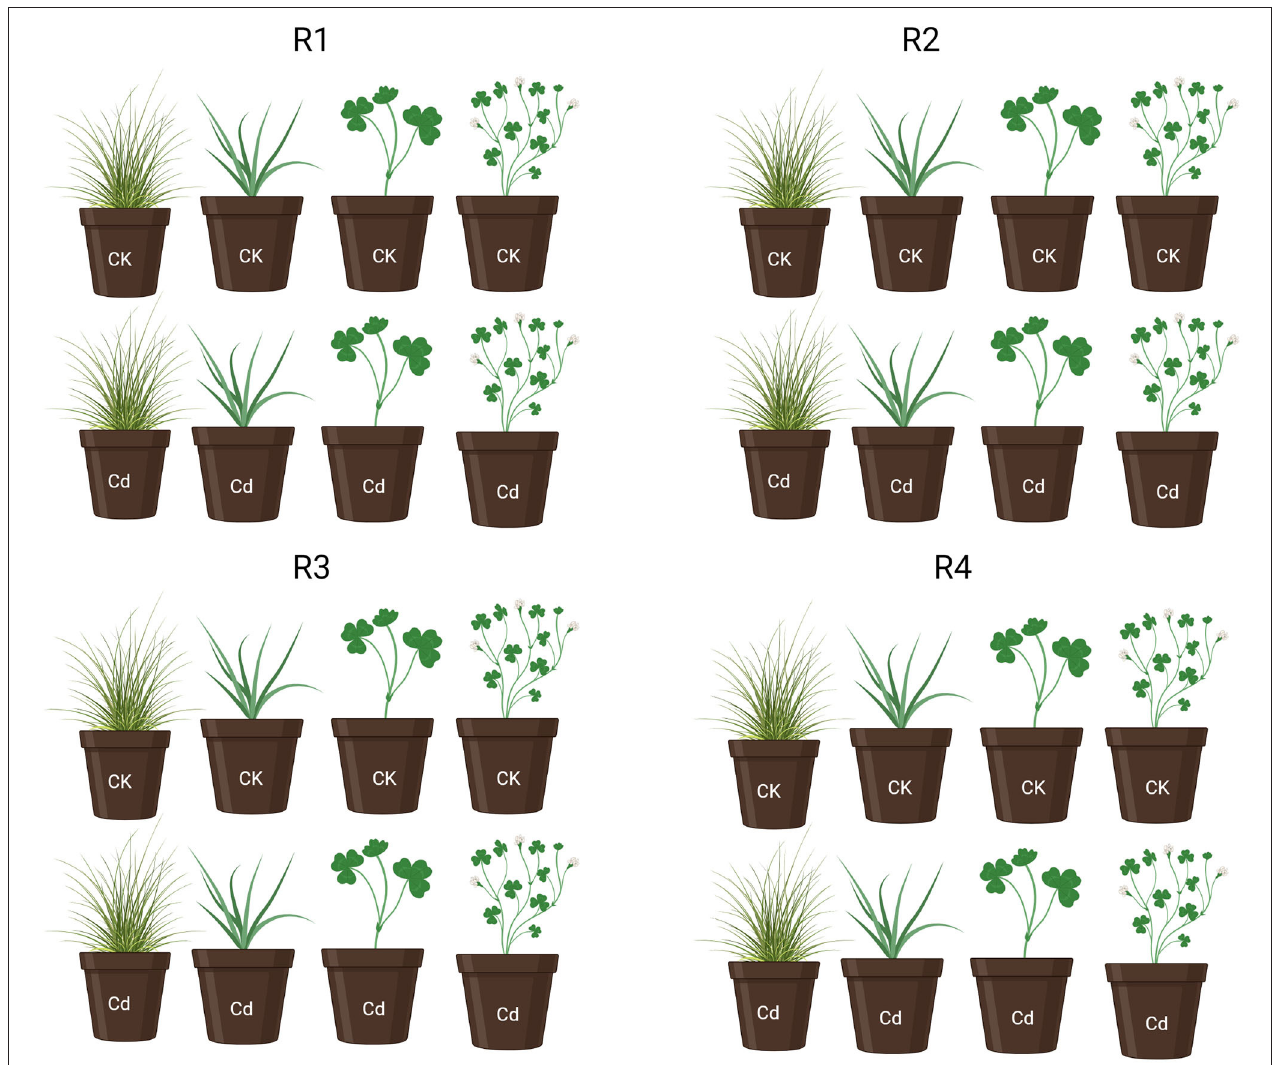
FIGURE 1 | Experimental design. Notes, CK, control, Cd, cadmium stress. Experimental layout. R1-4 mean replicates.